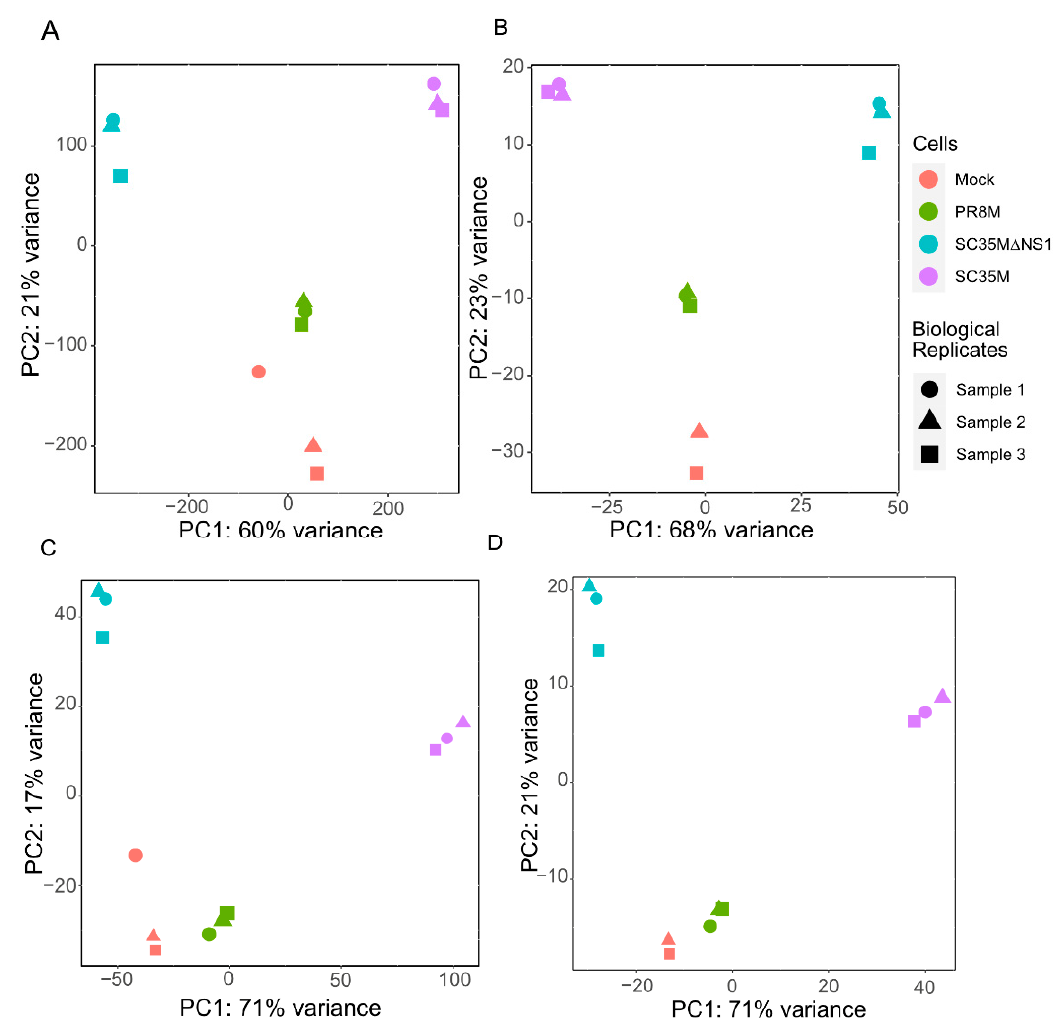
Figure 1. Principal component analysis (PCA) plots of the gene matrix ( A , B ) and HERV loci matrix ( C , D ). ( A , C ) PCA plots with all samples included. ( B , D ) PCA plots with the control sample 1 removed. Only one technical replicate is shown in all plots. See Appendix A (Figures A1 and A2) for the gene matrices of the other two technical replicates.